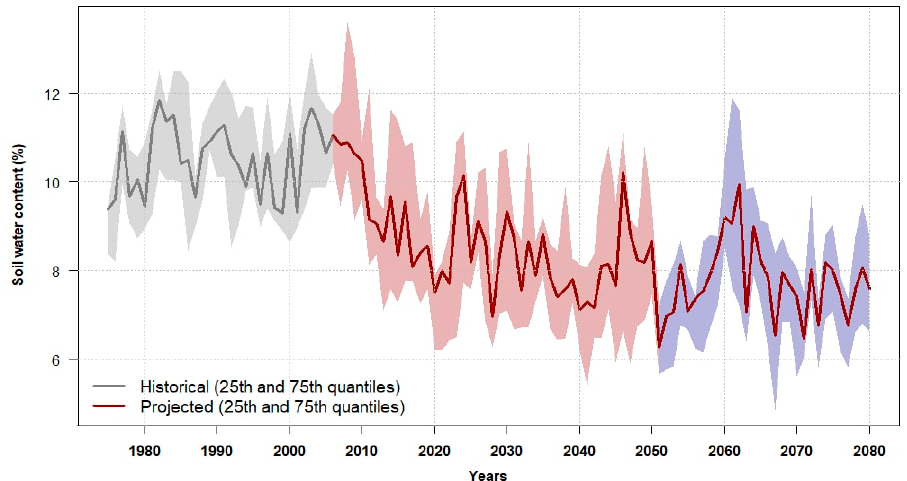
Figure 8. Soil water content relative to the reference period 1976–2005 mean for RCP8.5 over the region. Solid lines show the ensemble medians and the shadings show the interquartile ensemble spread (25th and 75th quantiles).